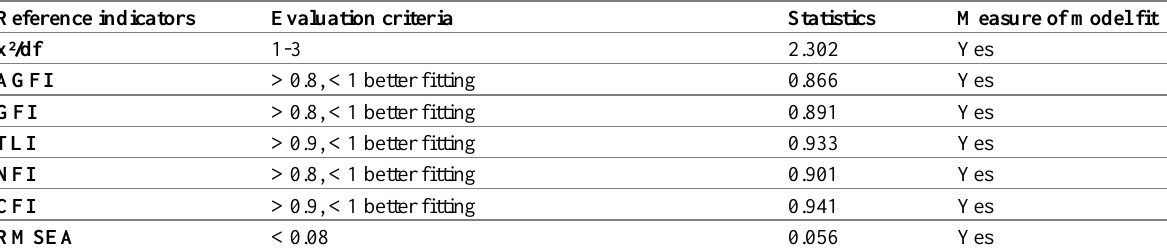
Figure 4: Structural equation model on the relation between content marketing and brand loyalty for “New Guochao” brands Table 5 as well as the comprehensive analysis of the structural equation on the relation between content marketing and brand loyalty for “New Guochao” brands reveal X2/df < 3 (standard value) and values of NFI, IFI, CFI in model fitting indicators > 0.9 (standard value), among which both GFI and AGFI > 0.8, RMSEA < 0.08 (standard value). This indicates that the model fitting ability is good. Consequently, the above data analysis shows that the goodness of fit in the structural equation model are relatively high and numerical indicators are fitting. Thus, the path analysis of the overall model can be carried out. Table 5: Indicators of the goodness of fit of structural equation model